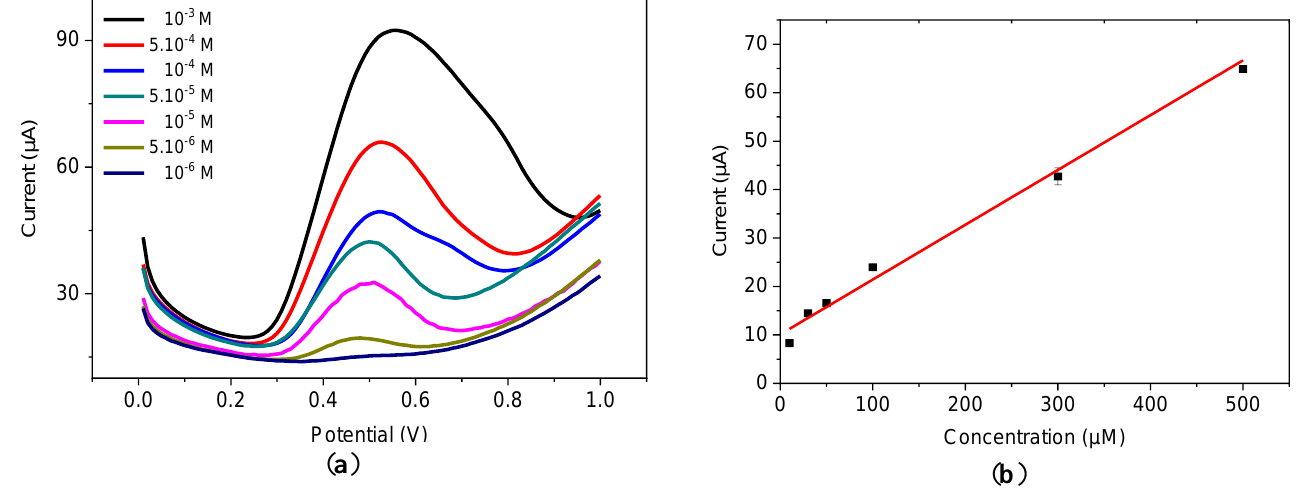
Figure 11. ( a ) DPV voltammograms for different concentrations of nitrite at scan rate = 50 mVs − 1 and ( b ) calibration curve.